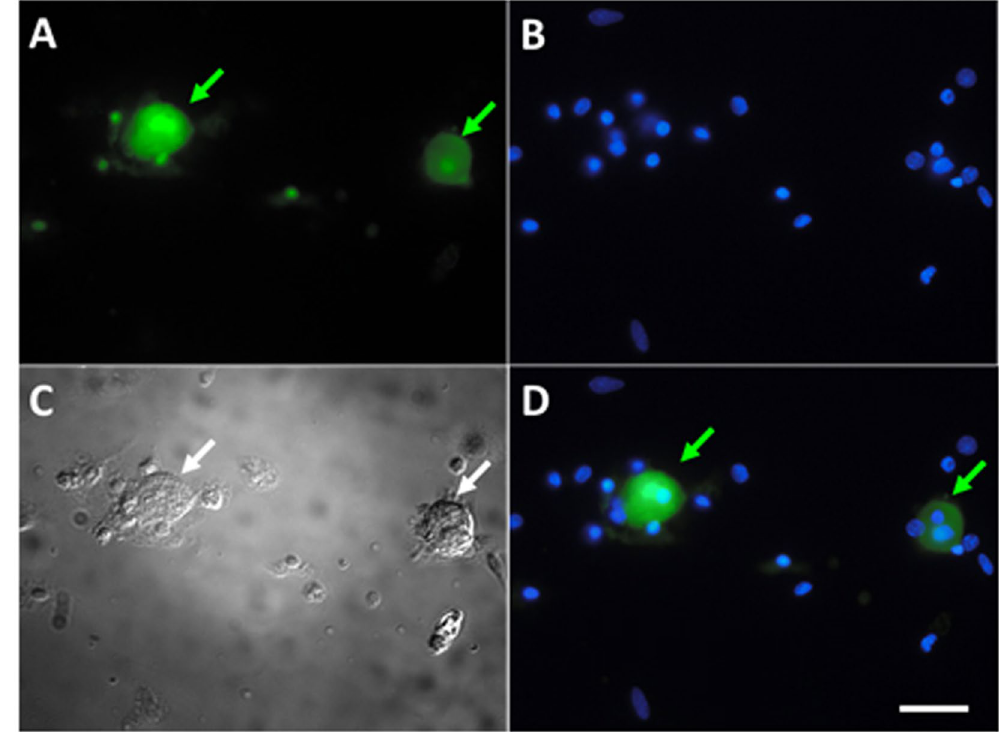
Figure 2. FITC-TAT-4BB predominately accumulates in acutely dissociated neurons ( A , green arrows). Nuclei of all cells are stained with DAPI ( B , blue). Bright field of representative acutely dissociated cells ( C ). Merged images are shown in ( D ). Scale bar is 20 μ